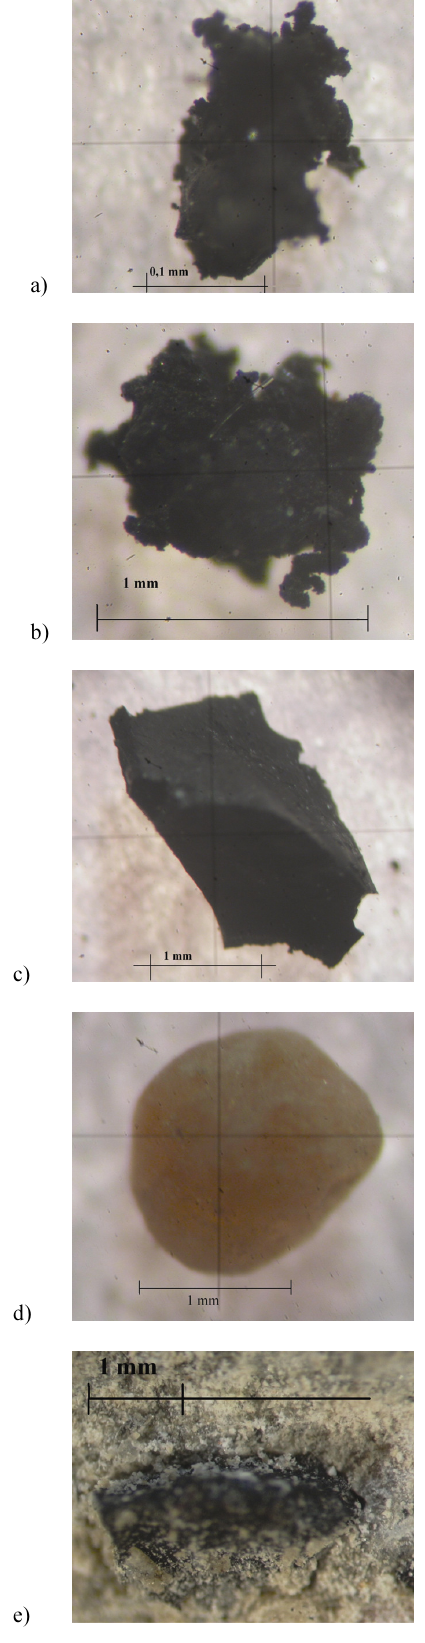
Fig. 8. Crumb rubber, particle size up to 0.5 mm ( a); Crumb rubber, particle size up to 1.0 mm (b); Crumb rubber, particle size up to 3.0 mm (c); Sand particle (d); Contact zone of cement matrix and a rubber particle (e)